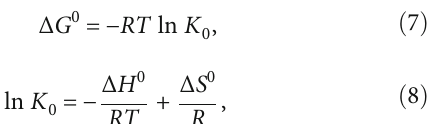
Table 1: The isotherm and kinetics parameters for the adsorption of MO dye on the surface of Fe Fe O 3 4